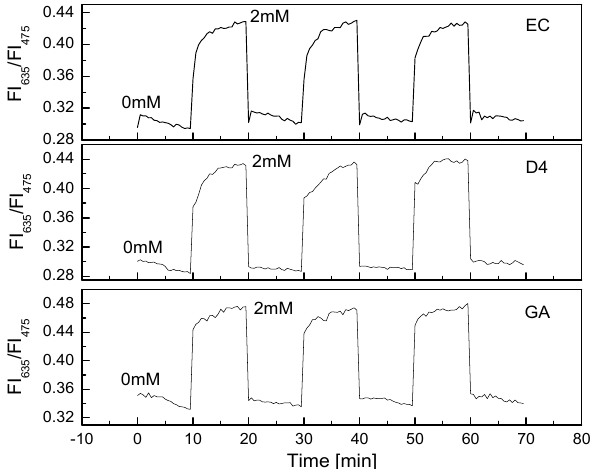
Figure 6. Reversibility of GOD = PS@C6^PtP membranes with different supporting materials (EC, D4, and GA) repeatedly exposed at 0 and 2 mM glucose.